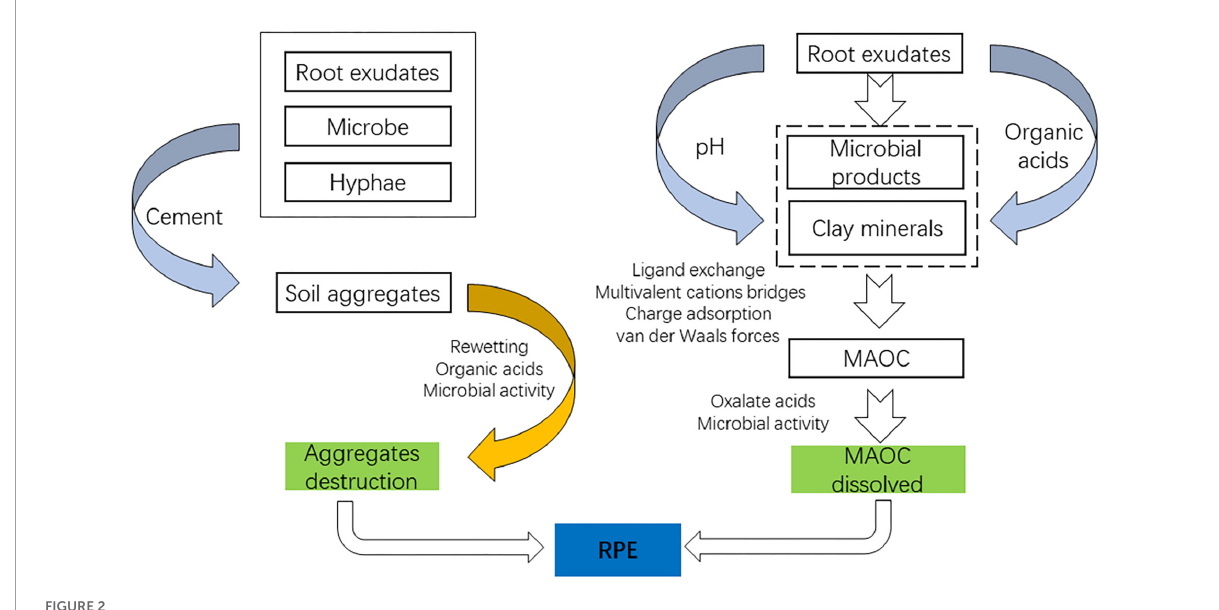
FIGURE2 Pathways of root exudates regulating